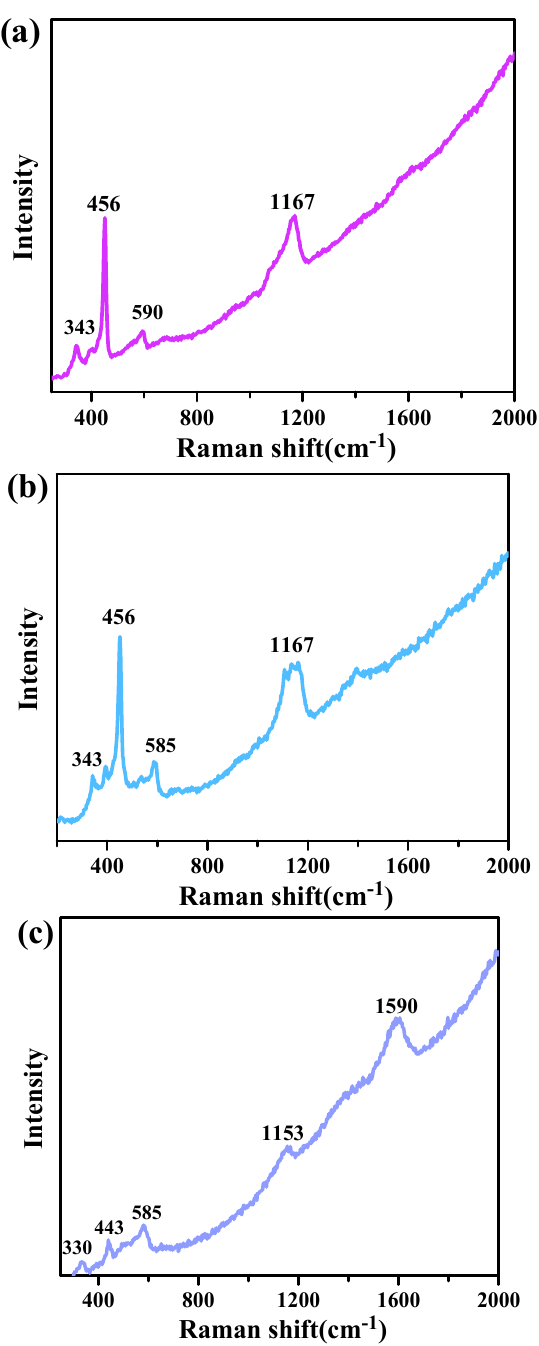
Figure 4. Raman spectra of ( a ) ZnO, ( b ) ZnO/Cel ( c ) ZnO@PPL/Cel.